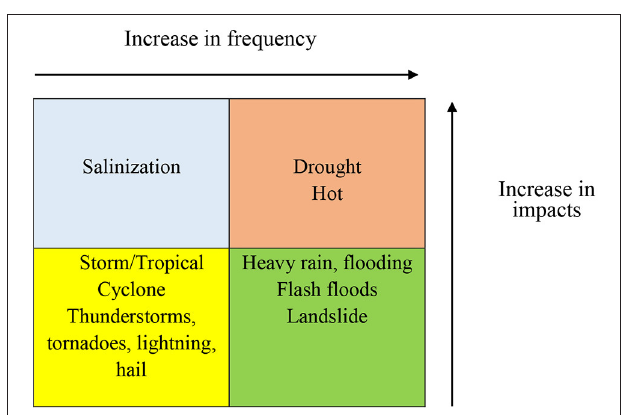
FIGURE 3 | Summary of natural disasters and pressure on agricultural production in Ninh